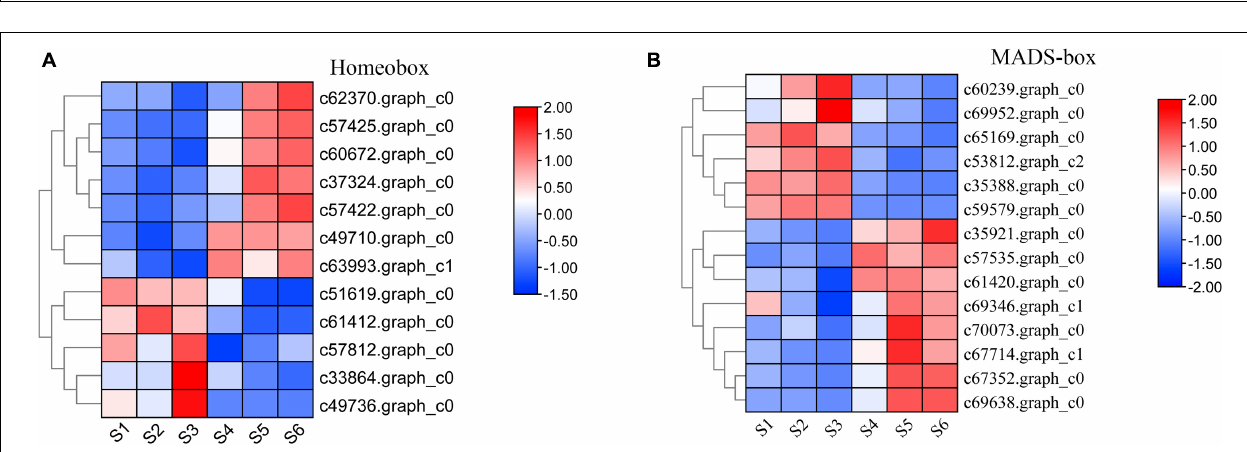
FIGURE 6 | KEGG annotations of differentially accumulated metabolites (DAMs) of the C . sinense ovule at three developmental stages (S2, S4, and S5). (A) Number of KEGG-annotated metabolites. Visualization, using a bar graph, of the identified metabolites from S2_vs_S4 (B) , and S2_vs_S5 (C) .